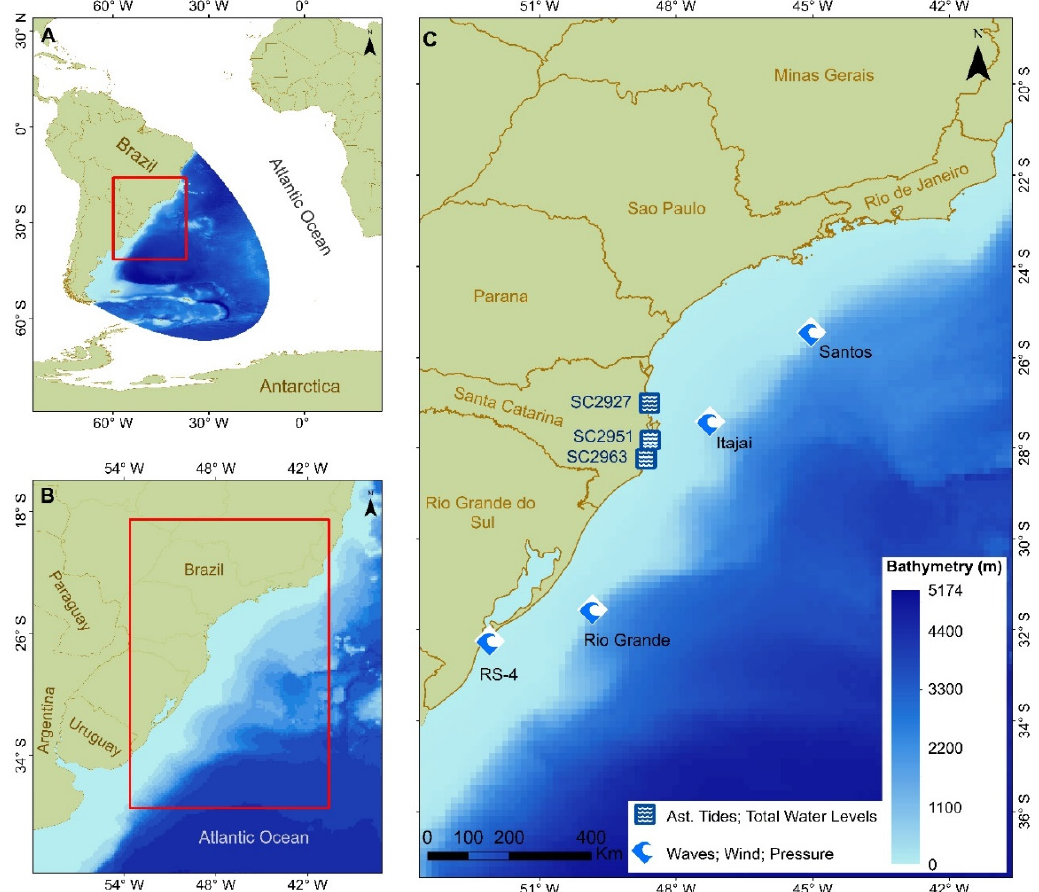
Figure 1. ( A ) Numerical modeling domain; ( B ) Southern Brazilian continental shelf; and ( C ) selected stations of which data were used for validation.